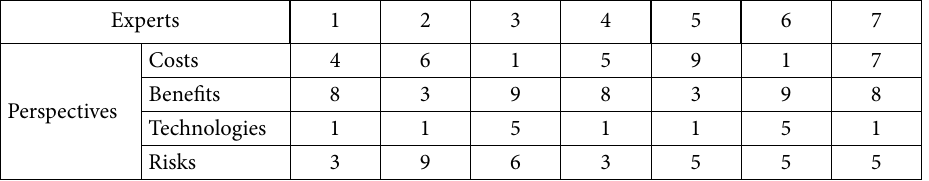
Table 8. The preferences of perspectives in OW